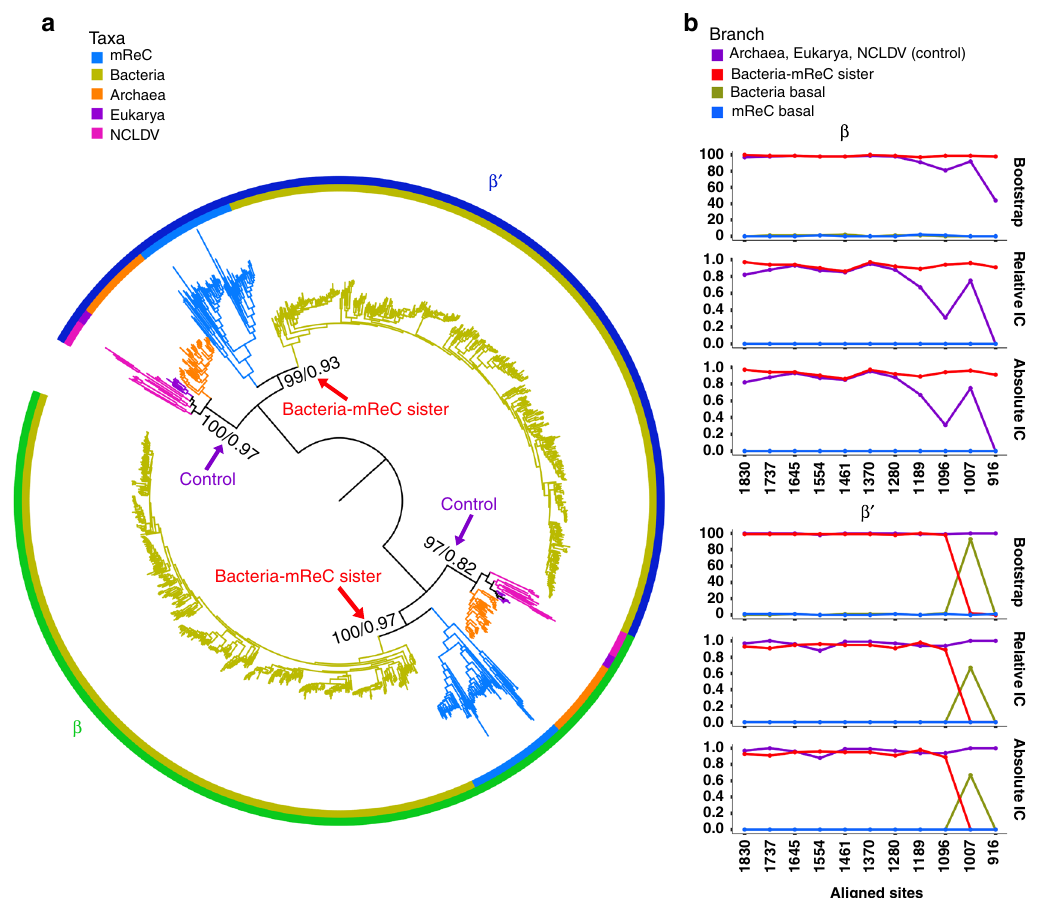
Fig. 6 Paralogy-based rooting analysis of the RNAP tree. a Rooted tree of β - and β ′ -subunits. Homologs of the β - and β ′ -subunits used for Eukarya were RPB2 and RPB1, and homologs B and A used for Archaea, respectively. Amino acid sequences for each subunit were aligned to each other, and phylogeny was constructed using maximum likelihood with the amino acid substitution model LG + C60 + F + Γ 4. Branch color and inner ring color strip corresponds to taxonomic group. Outer ring color strip corresponds to subunit β (green) and β ′ (blue). At selected branches, fi rst number refers to ultrafast bootstrap support of 1000 replicates reported as a percent out of 100 and the second number refers to relative Internode Certainty (IC) value out of 1. Arrows point to branches used to assess support of trees as fast-evolving sites were removed (see “ Methods ” ). b Line plots of branch support corresponding to different hypotheses in the β (upper) and β ′ (lower) clusters as fast-evolving sites are removed in steps of 5% until 50% of the fastest evolving sites are removed from the alignment (see “ Methods ” ). Purple corresponds to branch support of Archaea, Eukarya, and NCLDV RNAP together. Blue line corresponds to the branch supporting mReC RNAP is basal to all other lineages considered. Yellow line corresponds to the branch supporting bacterial RNAP is basal to all other lineages considered. Red line corresponds to the branch supporting that mReC and bacterial RNAP diverged together prior to other groups. Instructions for accessing full trees with support values can be found in the “ Data availability ”